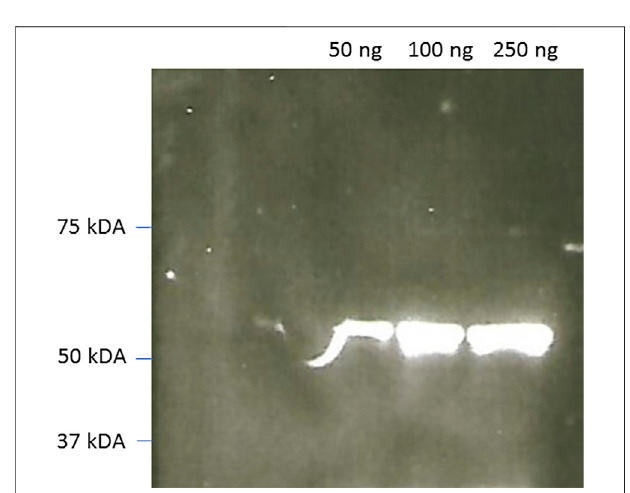
FIGURE 8 | CCD imaging of Western blots of commercial SARS-Covid- 2 nucleoproteín using rabbit Anti-SARS-covid and reveled using ZZ-AmyLuc fusion protein as a secondary antibody and its assay solution. Exposure time: 1